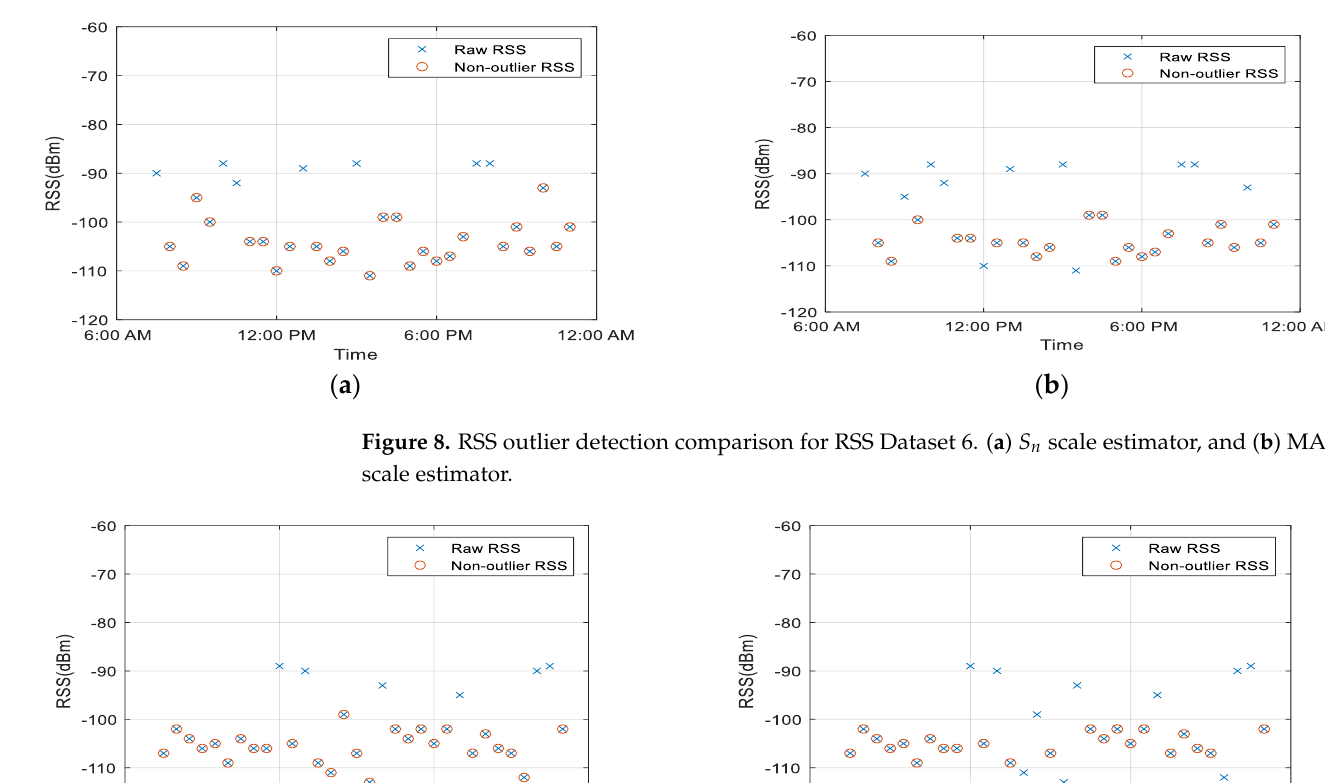
Figure 7. RSS outlier detection comparison for RSS Dataset 5. ( a ) 𝑆 𝑛 scale estimator, and ( b ) MAD scale estimator.